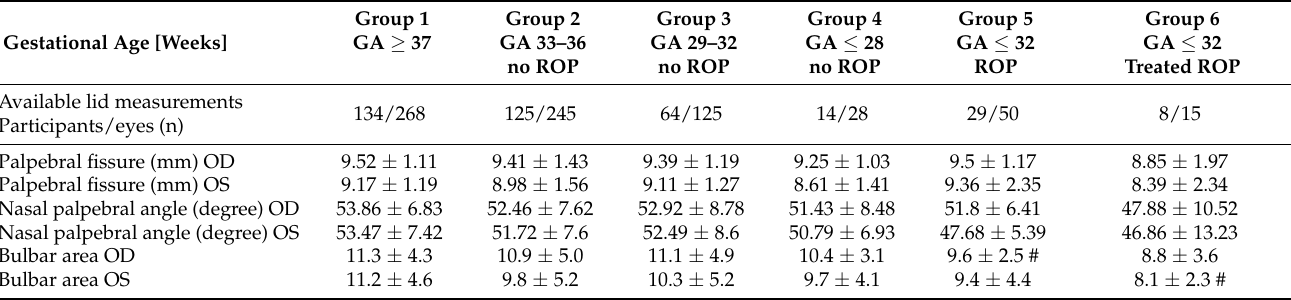
Figure 2. The relationship of gestational age to ( a ) bulbar redness, and ( b ) wetting in the Schirmer test in the Gutenberg Prematurity Eye Study. Figure legend 2: Individuals born preterm with low gestational age show an increased bulbar redness and a higher Schirmer test result. The line presents the Loess (Locally Weighted Scatterplot Smoothing) curve. Table 3. Lid parameters of the study groups.